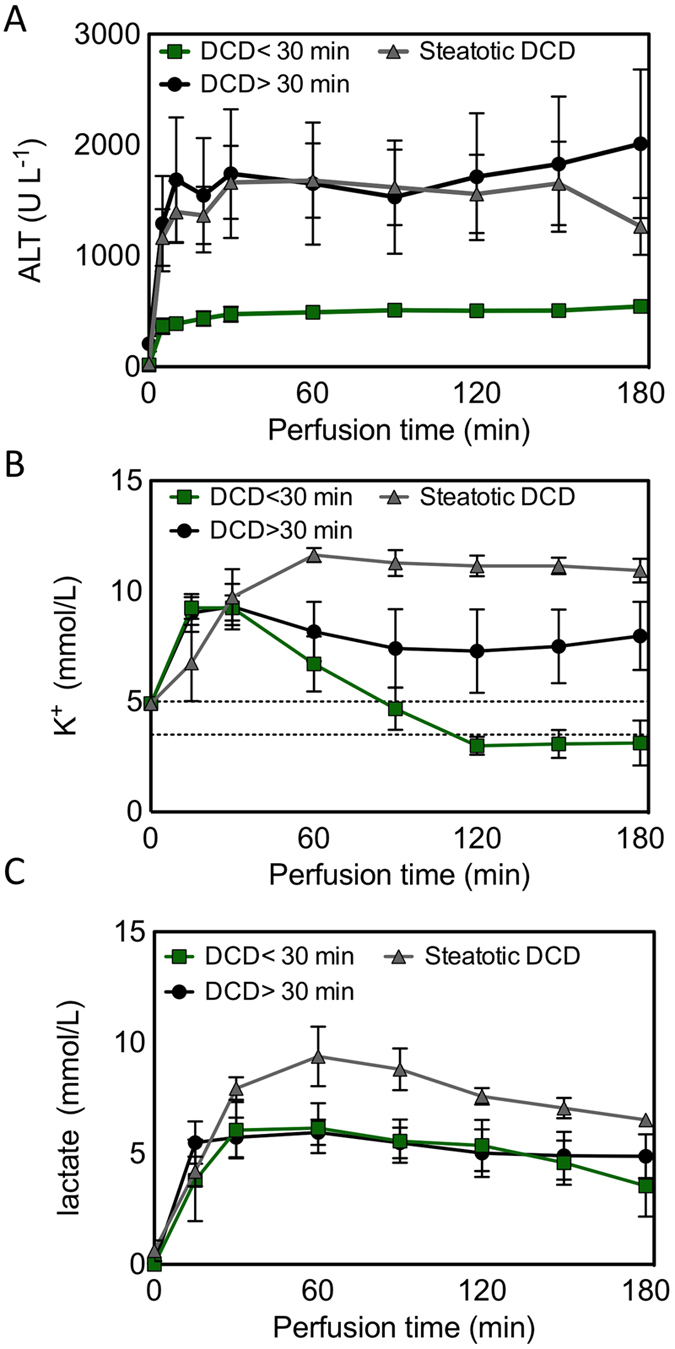
Injury markers between control DCD, steatotic, severely warm ischemic livers.(A) Levels of alanine transaminase (ALT), (B) potassium, and (C) lactate in the perfusate throughout 3 hours of SNMP. Dashed lines reflect normal blood reference values for potassium. Data shown as mean ± sem.